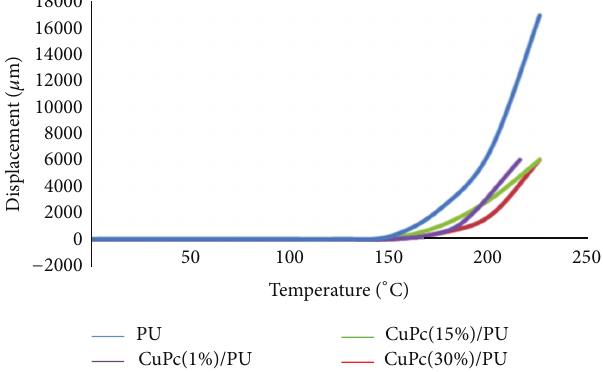
Figure 6: Storage modulus (`E) for the PU, CuPc(1%)/PU, CuPc(15%)/PU, and CuPc(30%)/PU samples. Figure 7: Irreversible deformation of PU, CuPc(1%)/PU, CuPc(15%)/PU, and CuPc(30%)/PU